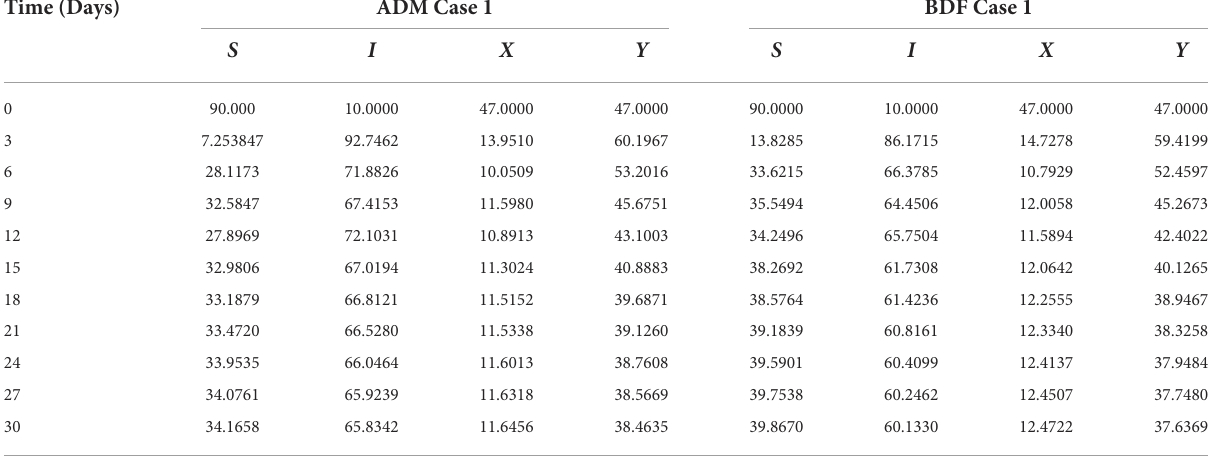
TABLE 4 Numerical outcomes of non-linear PVPMV model A1 for case-1 of scenario 5. Time (Days)